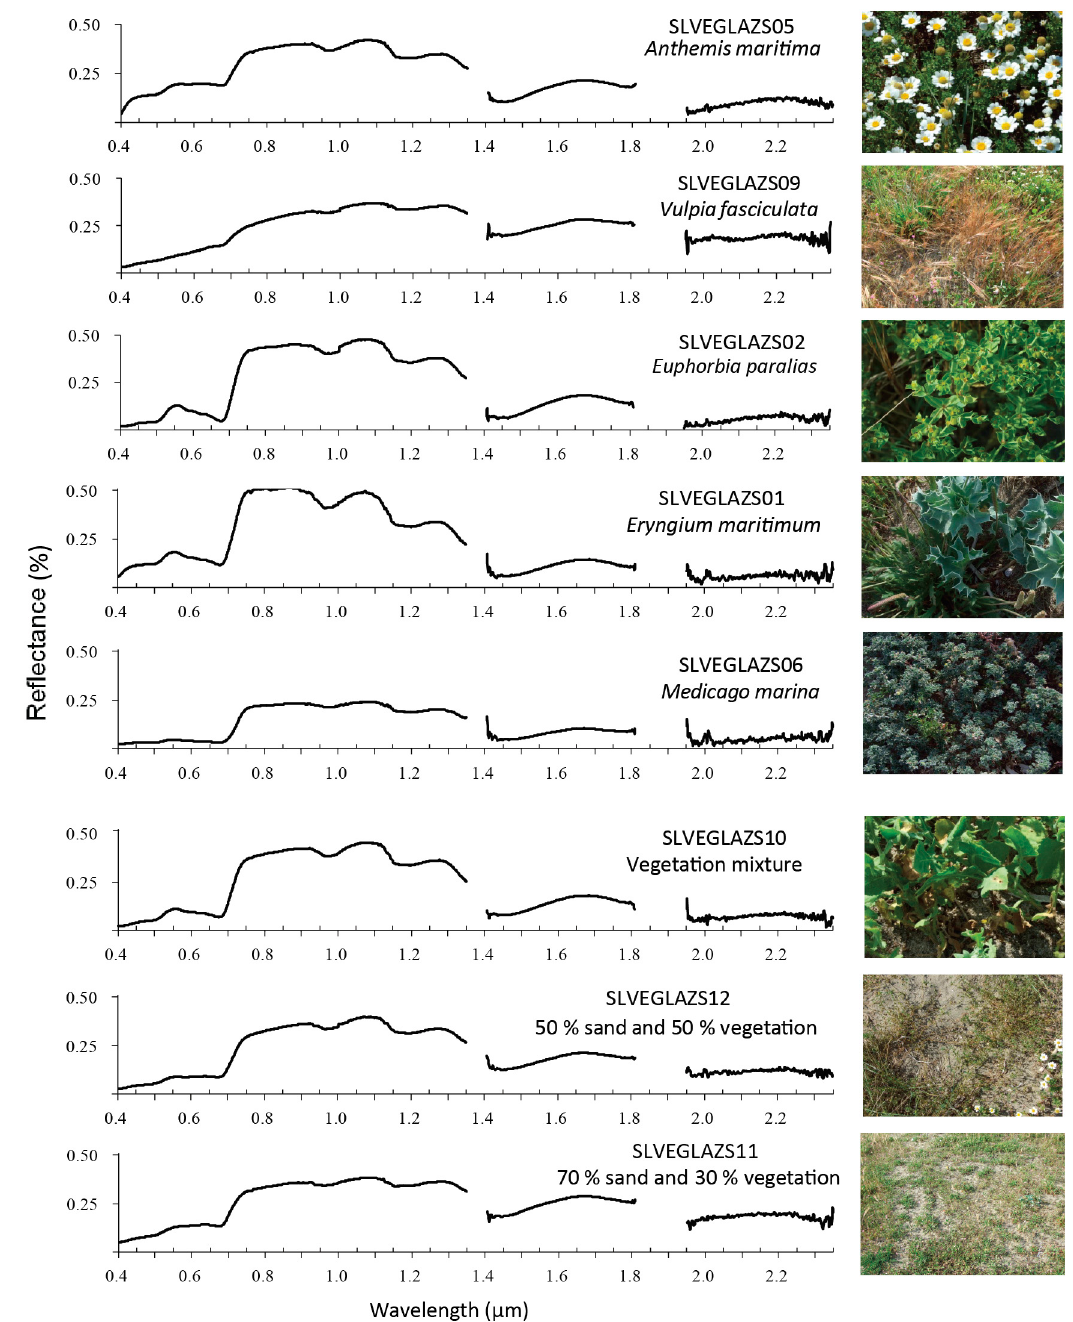
Figure 3. Field spectral library of herbaceous and shrub vegetation typologies collected during the field campaign.